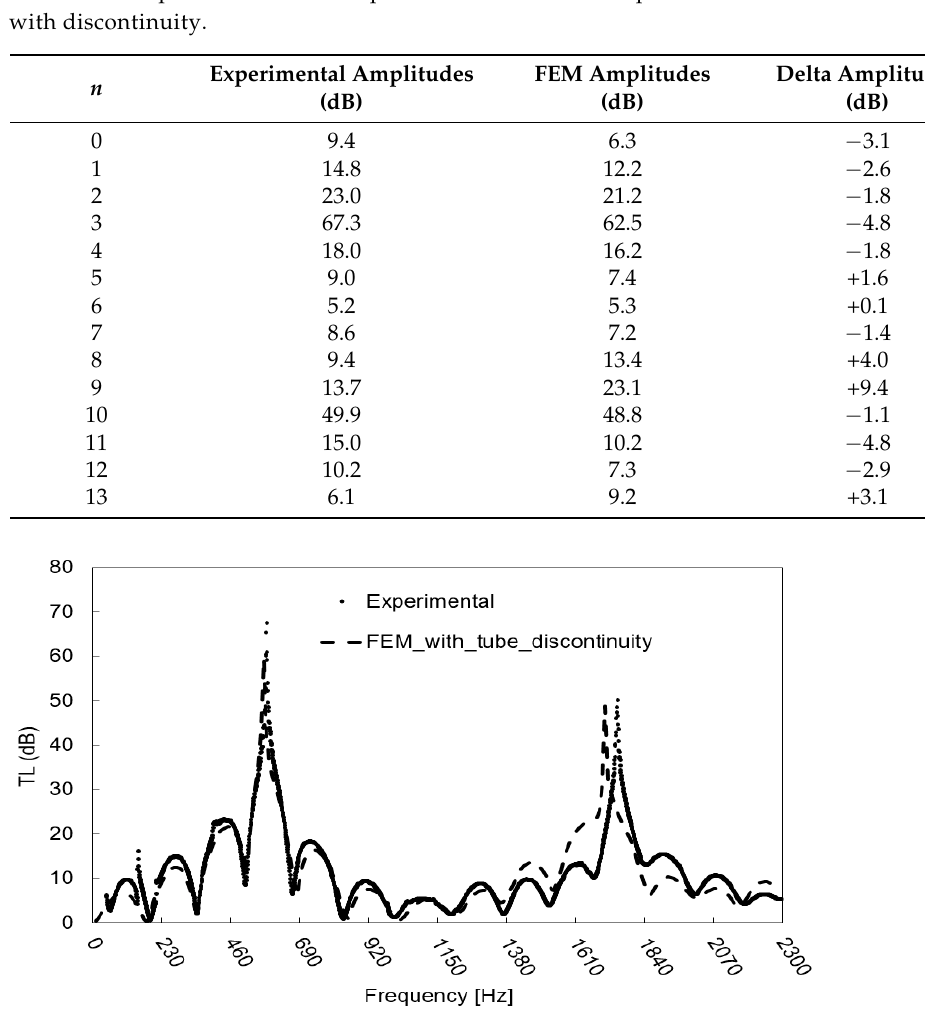
Figure 13. Comparison between experimental and FEM-simulated TL of the model-scale scrubber with discontinuity. Table 7. Comparison between experimental and FEM f min and f max of TL for the model-scale scrubber with discontinuity.